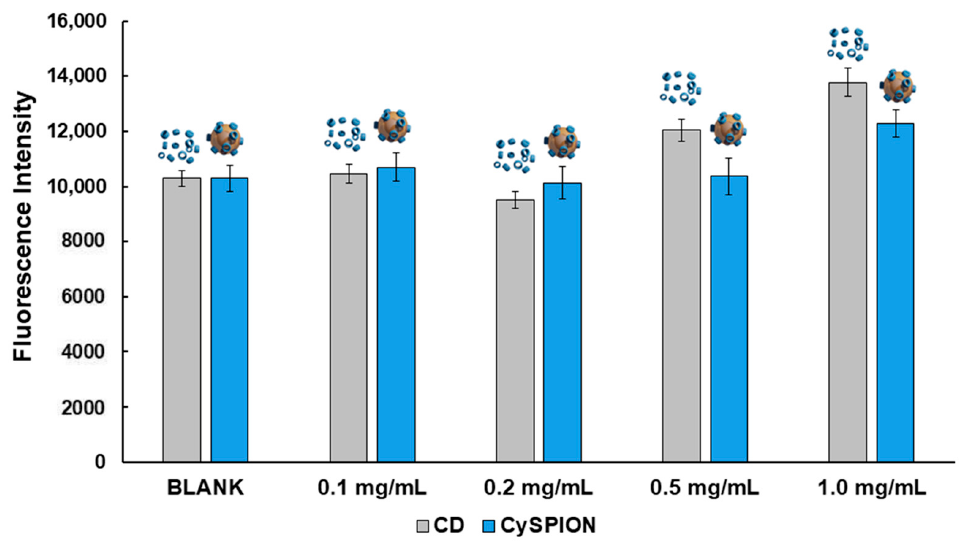
Figure 1. Cholesterol quantification assay using an enzymatic kit in Npc1-deficient CHO cells for CySPION and CDen. The CySPION solubilizing effect on cholesterol was slightly less efficient in comparison to the monomeric macrocycle at an equivalent CD concentration.